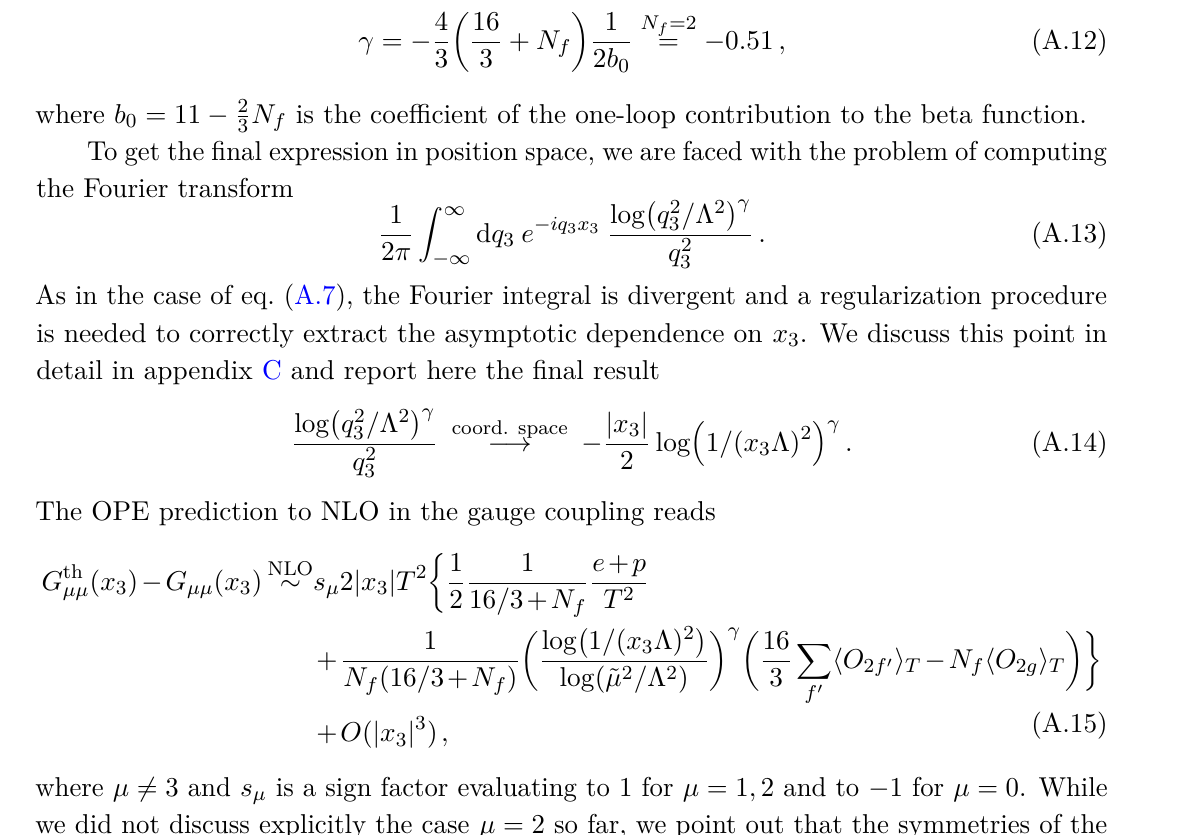
Figure 7 . Difference between the thermal and vacuum correlation functions G th for µ = 0 (left) and µ = 1 (right) at small x 3 in the free theory. The black dashed line represents the OPE prediction for this quantity truncated at leading order in x 3 , and the red dotted line is obtained by subtracting [ G th − G µµ ] x from the red µµ 3 =0